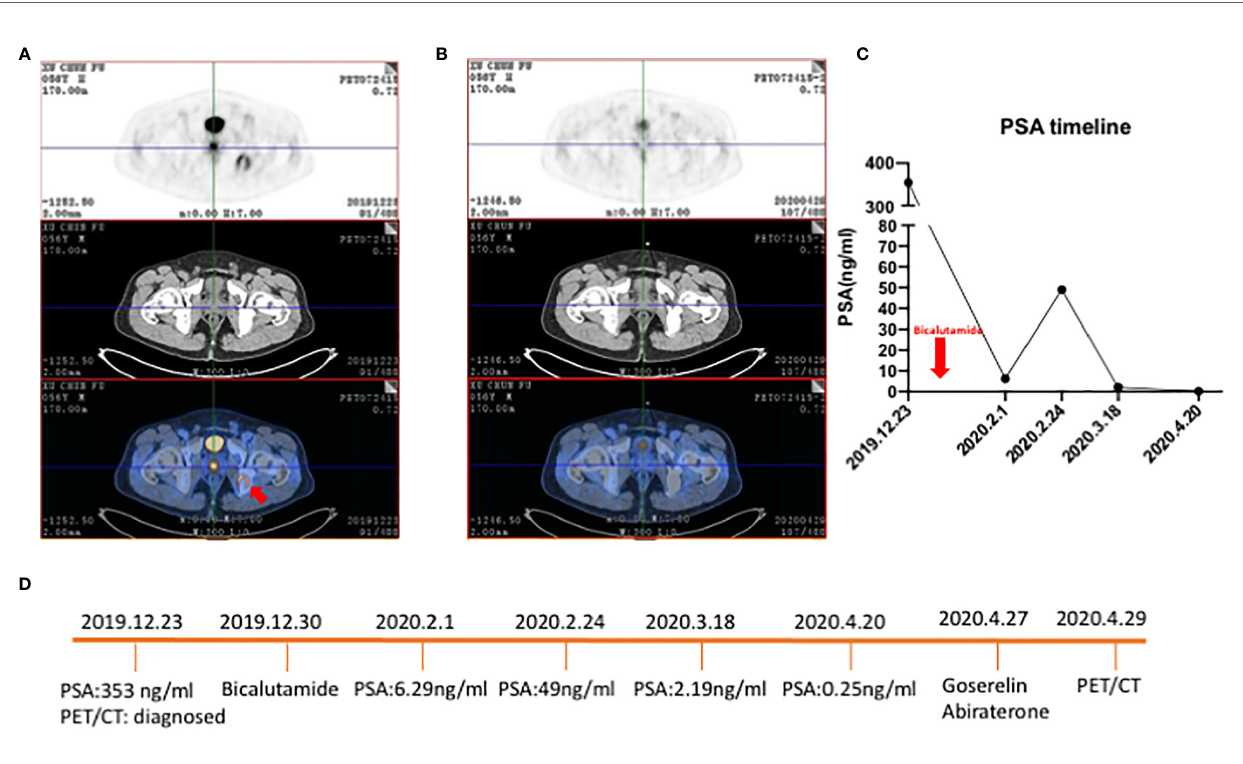
FIGURE 1 | 18 F-FDG PET/CT of a 56-year-old patient with primary prostate cancer who was sensitive to ADT. (A) Patient was diagnosed with primary prostate cancer and an oligometastatic lesion in the right ischium (red arrow) with an osteogenic bone lesion. SUVmax of primary prostate cancer was 7.2. (B) After ADT tumor burden was signi fi cantly decreased and the oligometastatic lesion regressed. (C) Line graph of PSA level. The red arrow was the timepoint patient taking bicalutamide. (D) Timeline of patient underwent ADT and time for